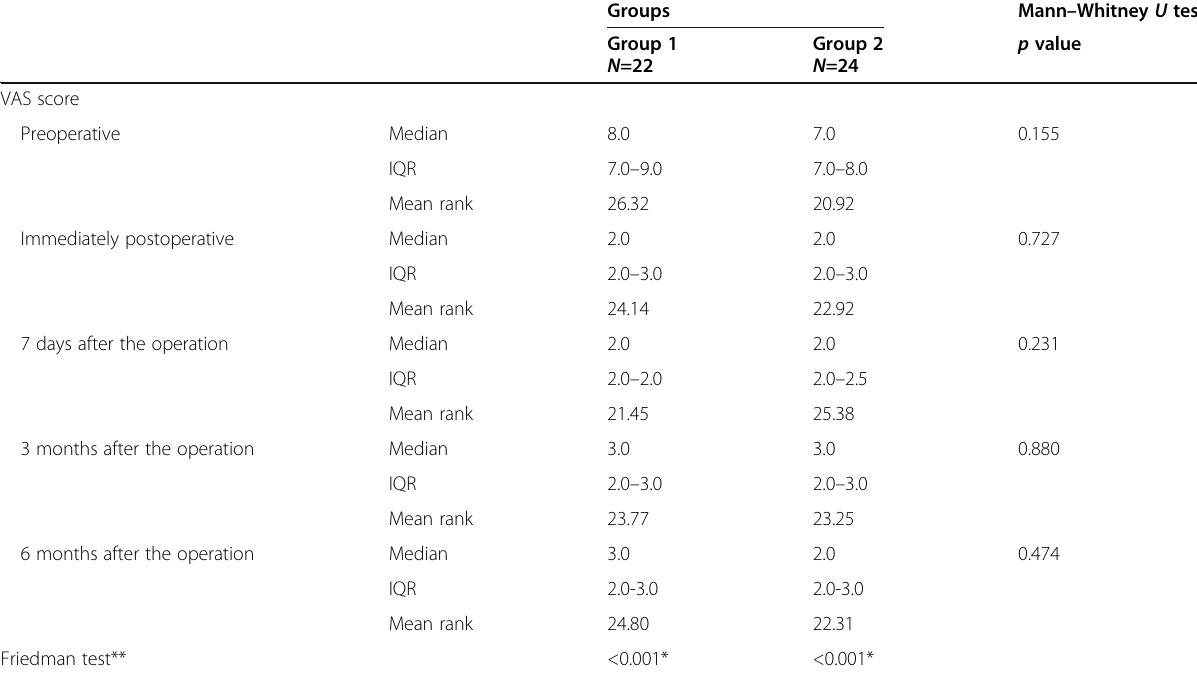
Table 2 Comparison of preoperative and postoperative VAS scores in the studied groups